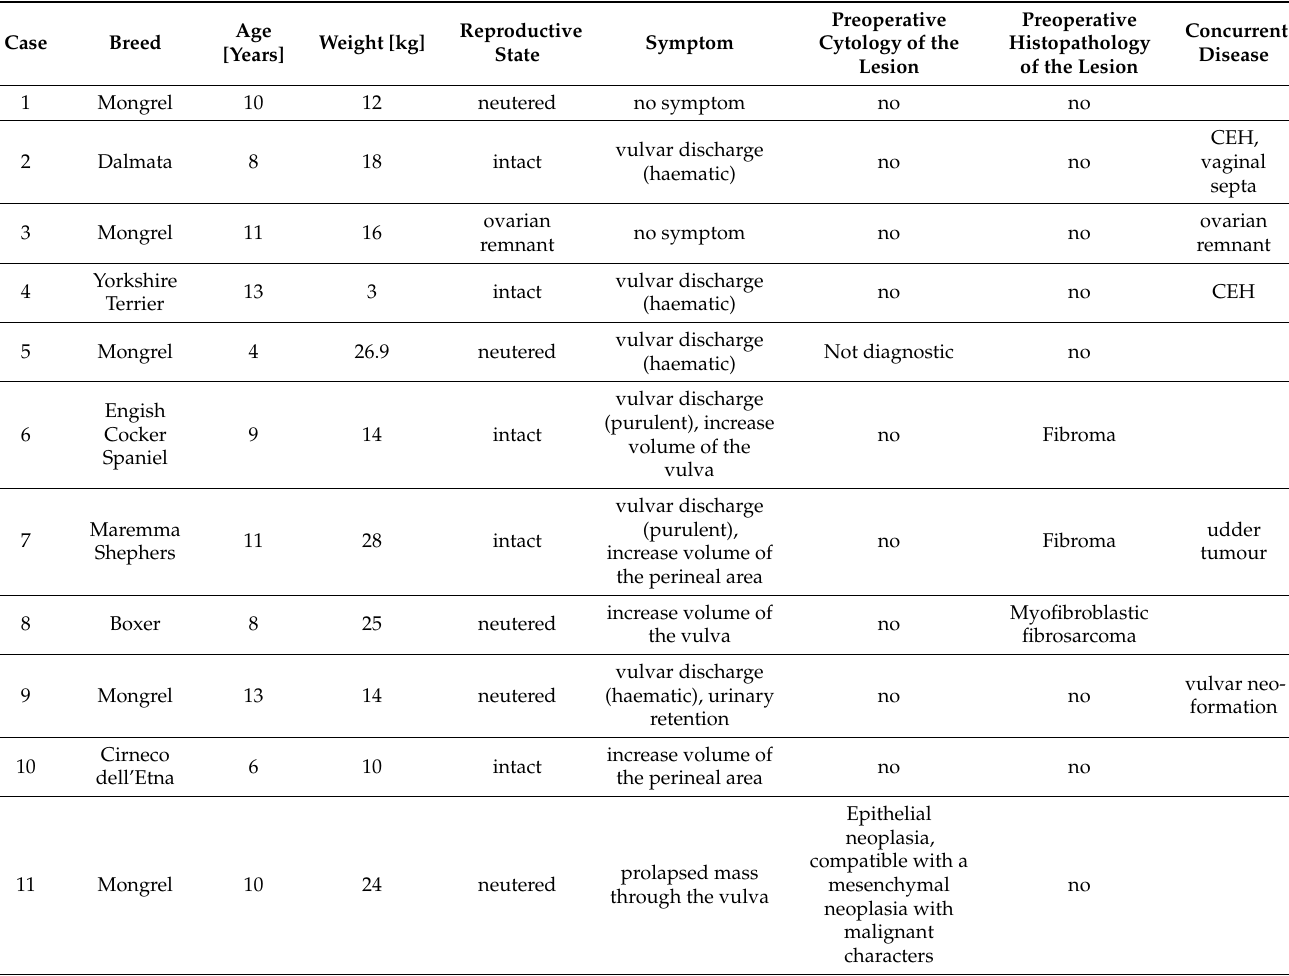
Table 2. Signalment and symptoms presented at the first visit, cytological evaluation of the lesion and concurrent